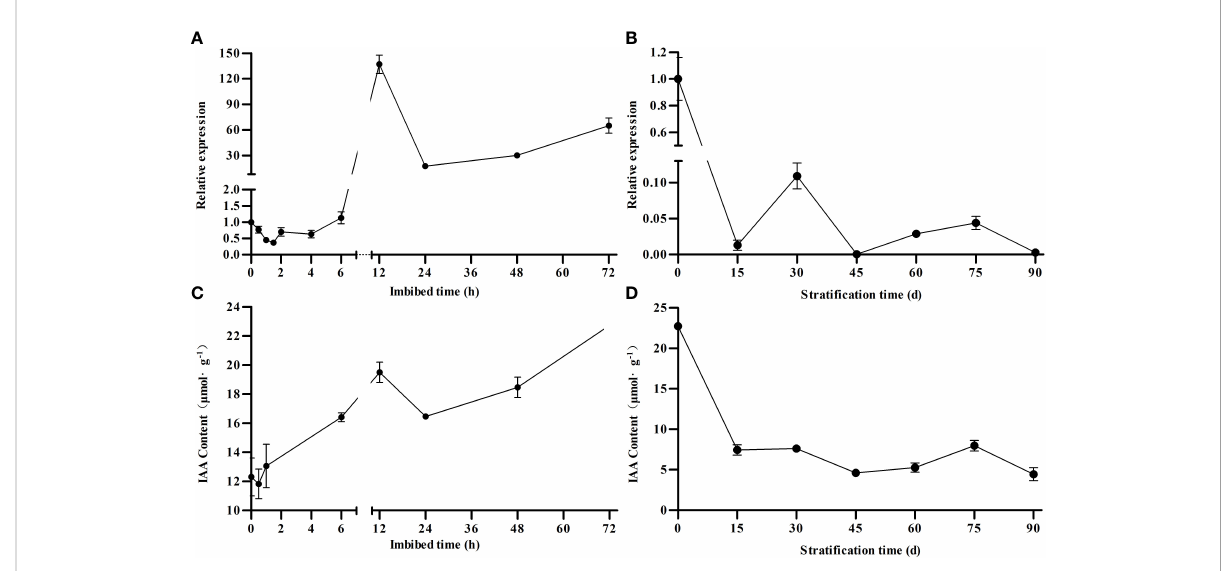
FIGURE 3 Correlation between MsARF5 expression and auxin concentration following seed strati fi cation and imbibition. (A, B) : relative expression of MsARF5 following strati fi cation and imbibition. (C, D) : auxin concentration following strati fi cation and imbibition.